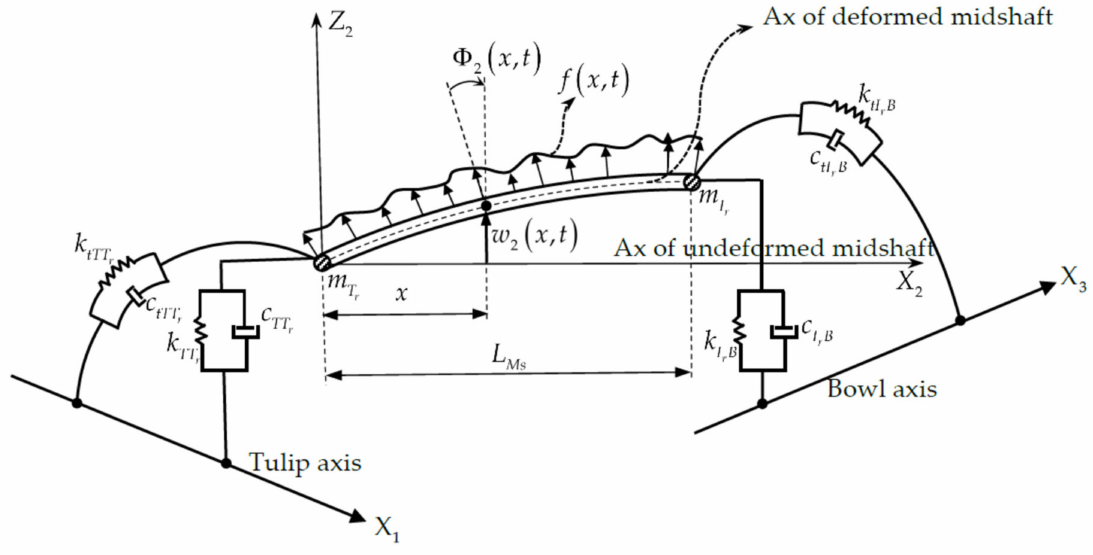
Figure 8. The part of the DMFFBV for the